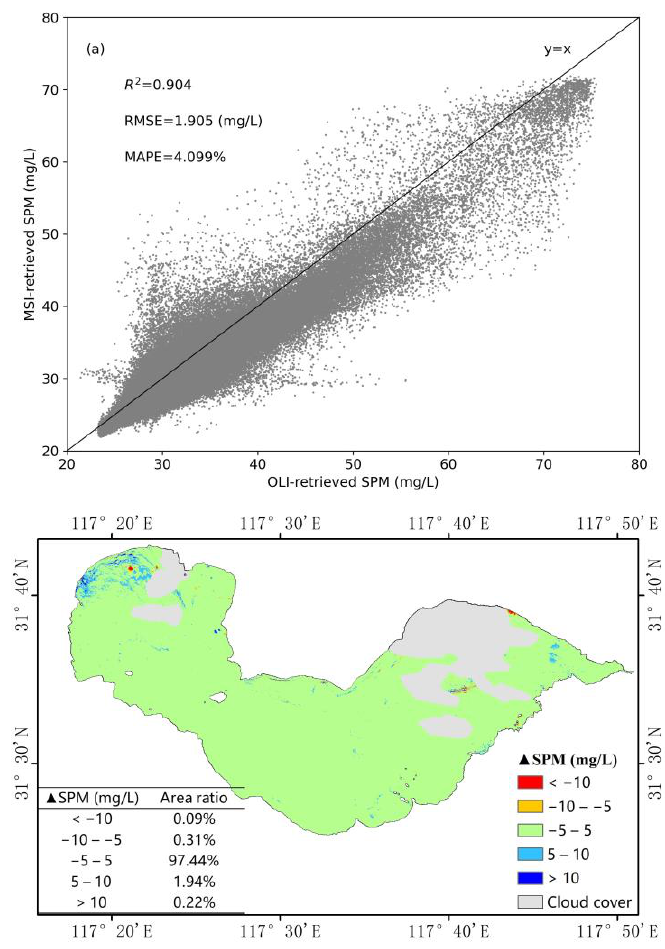
Figure 5. Comparison of SPM retrieval values from OLI and MSI images in Chaohu Lake, using the same model: ( a ) Correlation of retrieval values, ( b ) difference of retrieval values.